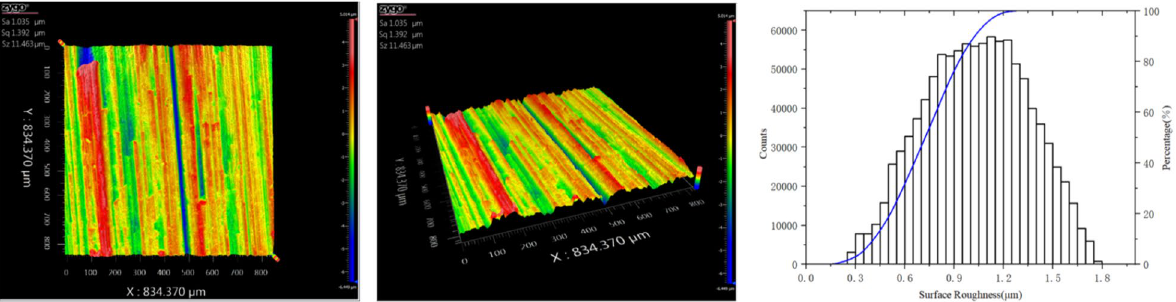
Figure 6 ( f 0.1 mm/r, v 260 m/min) 3D morphology, 2D morphology and roughness distribution curve of machined surface = =